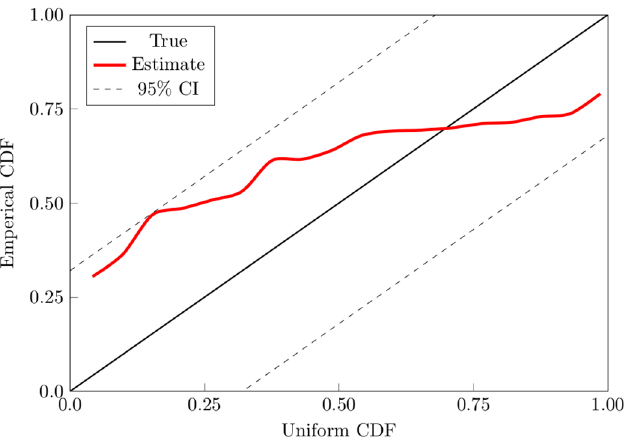
Fig 3. Goodness-of-fit assessment (K-S plot) of proposed model. If the model describes the data well, the estimated distribution should follow a forty-five degree line. The 95% confidence intervals for the Kolmogorov-Smirnov statistic are computed by u m (cid:7) 1 : 36 = ð cumulative distribution (CDF) of a uniform random variable, m = 1, 2, (cid:4)(cid:4)(cid:4) , n , and n is the number of interspike intervals. Results show that the Poisson model does not describe the data well.